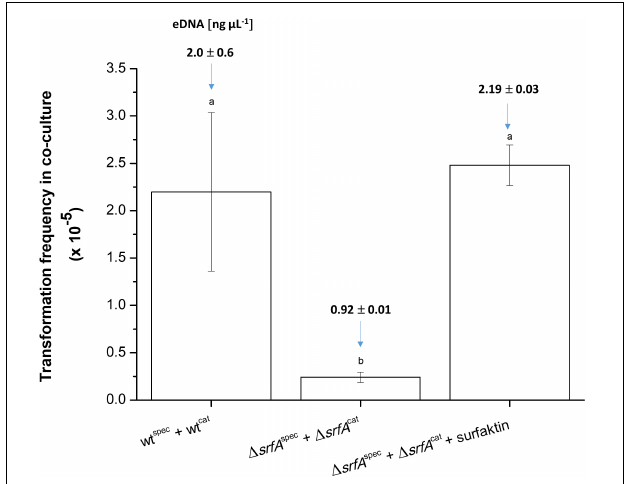
FIGURE 4 | Transformation frequency in co-cultures of wt cat (BM1060) + wt spec (BM1058) and (cid:49) srfA cat (BM1062) + (cid:49) srfA spec (BM1063) without or with surfactin (20 µ g ml − 1 ) during growth in CM medium for 8 h at 37 ◦ C and 200 rpm. In each experimental variant, the eDNA concentration was determined before the transformation assay and is depicted as the number above each column. The values presented are means and standard errors ( n = 3). Different letters above the columns indicate a statistically significant difference ( p < 0.05) between mean values across all strains and treatments (i.e., across all